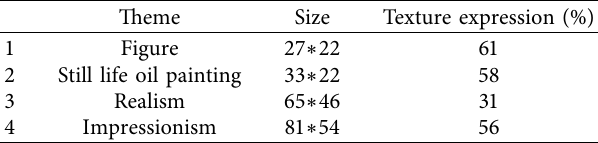
Figure 6: Representative oil Table 1: Content parameters of oil painting. Table 4: Statistics on the content of the improved oil painting.